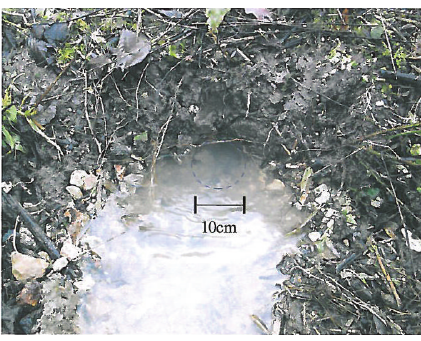
Figure 6: 10 cm diameter resurgence observed at the foot of the downstream